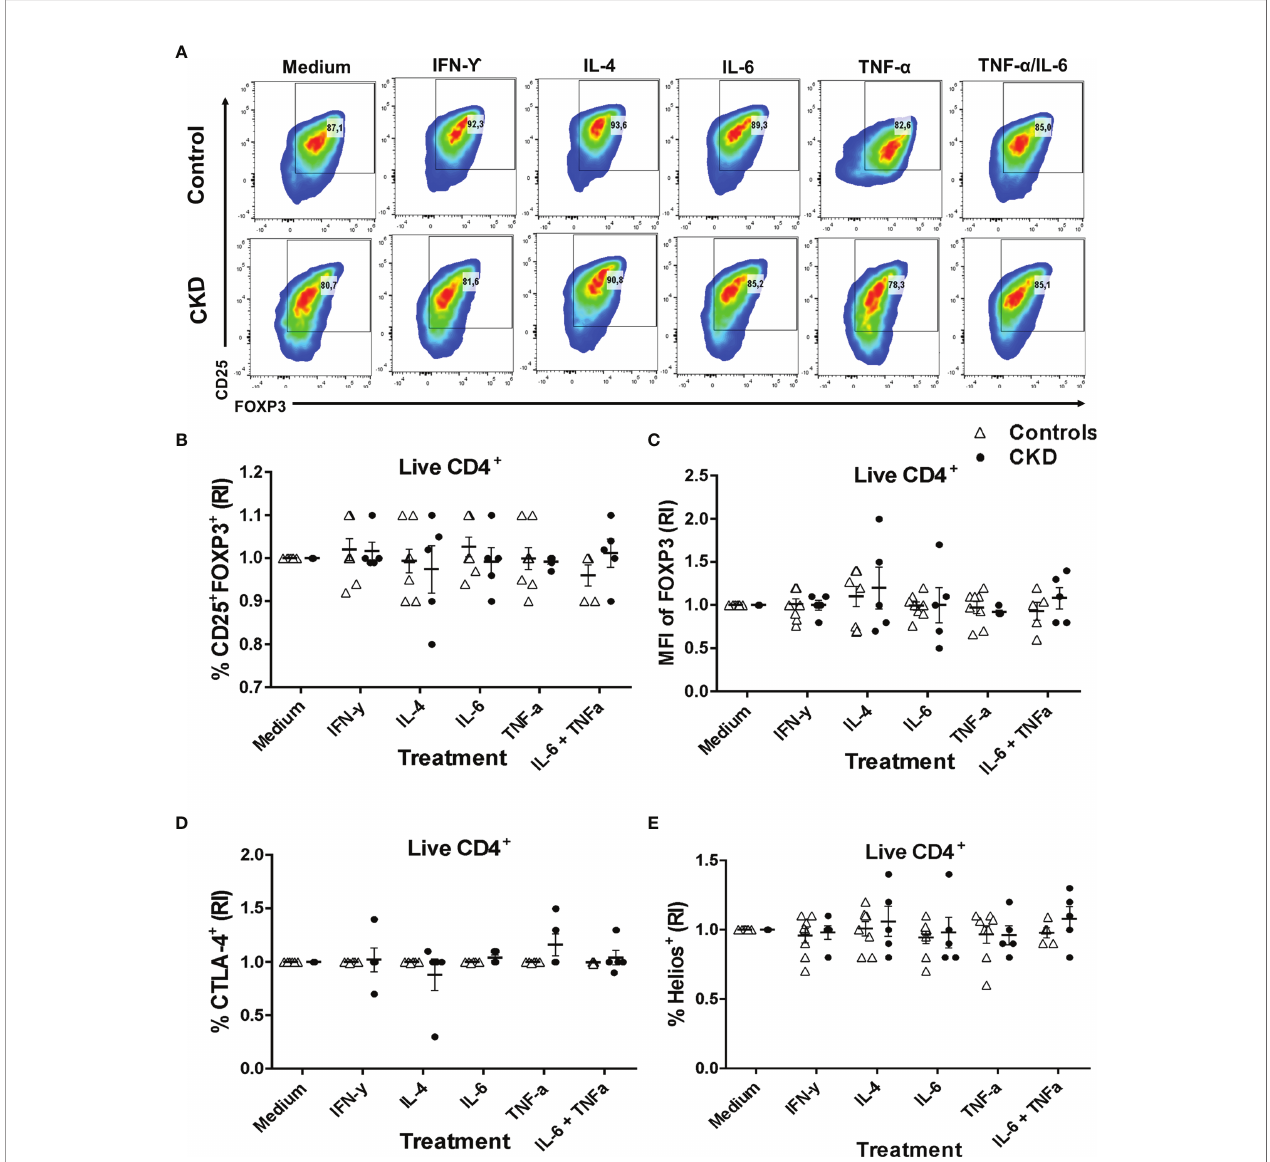
FIGURE 6 | Expanded alloantigen-speci fi c regulatory T cells (Tregs) maintain their immunosuppressive phenotype after stimulation in an in fl ammatory microenvironment. Long-term expanded Tregs from healthy controls ( white triangles , n = 7) or patients with chronic kidney disease (CKD) ( black circles , n = 5) were stimulated with anti-CD3/anti-CD28 in the presence or absence of in fl ammatory cytokines (IFN- g , IL-6, IL-4, or TNF- a ) for two additional weeks. The expressions of Treg markers were determined by fl ow cytometry. (A – D) Activation of allospeci fi c Tregs from CKD patients in the presence in fl ammatory cytokines did not have an effect on the percentages of CD25 + FOXP3 + (A, B) , CTLA-4 + (D) , and Helios + (E) cells and on the expression of FOXP3 (C) to the same extent as the Tregs from healthy controls. A representative experiment is shown in (A) . The relative increase (IR) of the percentage or median fl uorescence intensity (MFI) was calculated by dividing the value in the presence of the cytokine by the value in the absence of cytokines (medium). The results are shown as the mean ± SEM. Statistical analysis was performed using the Kruskal – Wallis test. No signi fi cant differences were